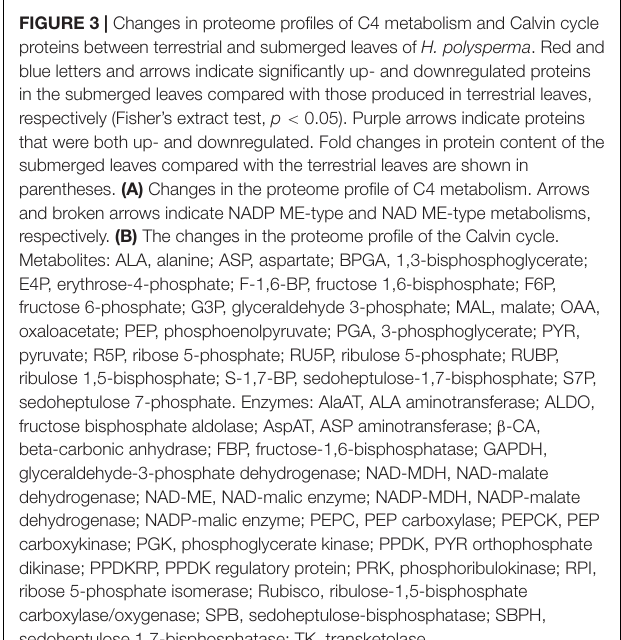
conditions ( Figure 3B ). HCO 3 − use mechanism in H. polysperma is an effective way to acclimate to submerged environment. HCO 3 − uptake and/or underwater photosynthesis in plants ranging from algae to higher plants (Nakajima et al.,